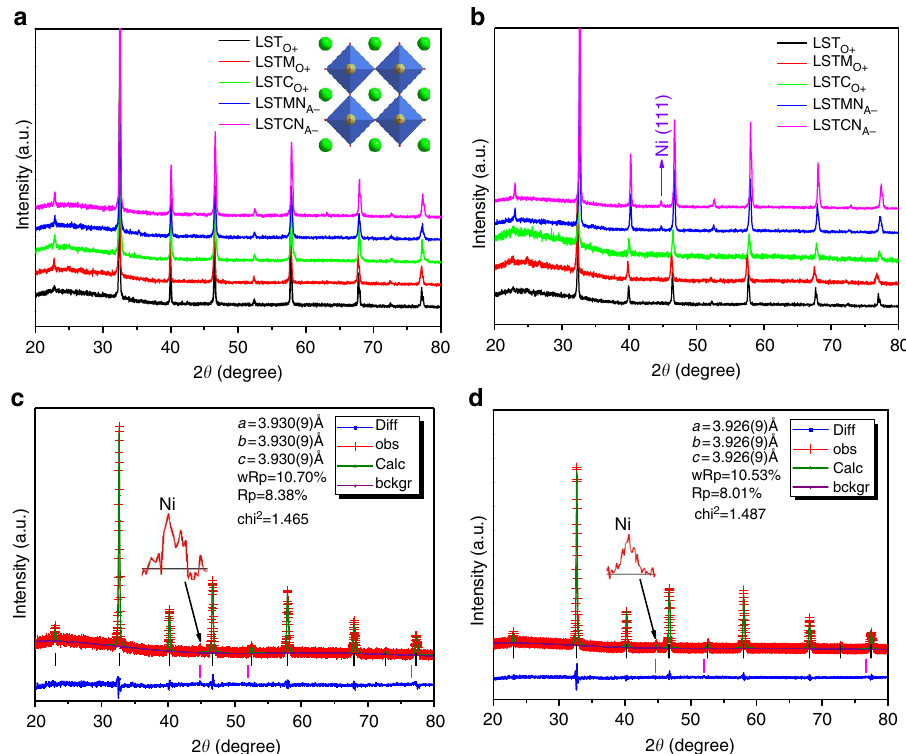
Figure 1 | X-ray diffraction patterns for a series of samples. X-ray diffraction of ( a ) oxidized and ( b ) reduced LST O þ , LSTM O þ , LSTC O þ , LSTMN A (cid:2) and LSTCN A (cid:2) ; X-ray diffraction Rietveld refinement of reduced ( c ) LSTMN A (cid:2) and ( d ) LSTCN A (cid:2) . bckgr, background; calc, calculated; diff, difference; obs,